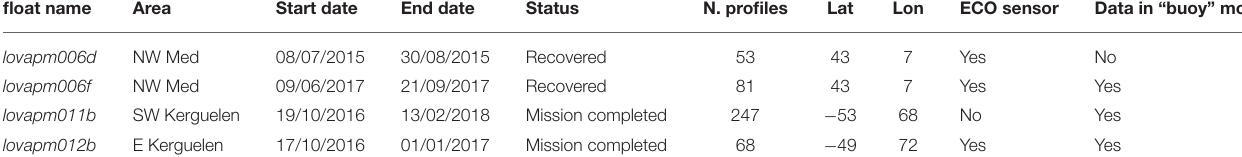
TABLE 3 | Summary of the deployments with a total of 449 profiles.